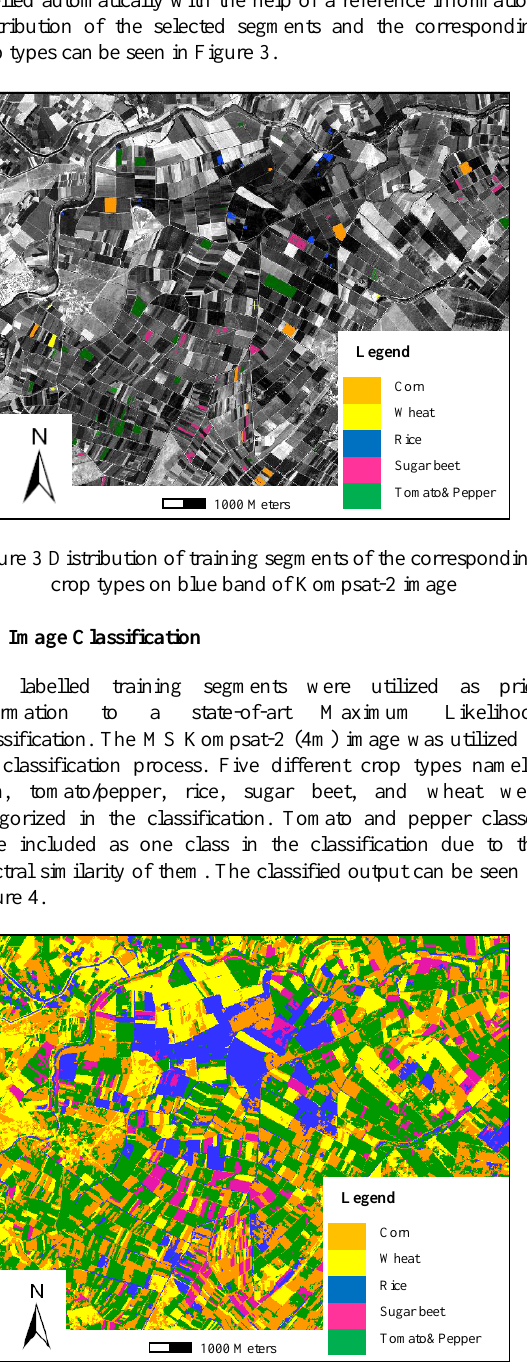
Figure 4 Thematic map of the MS Kompsat-2